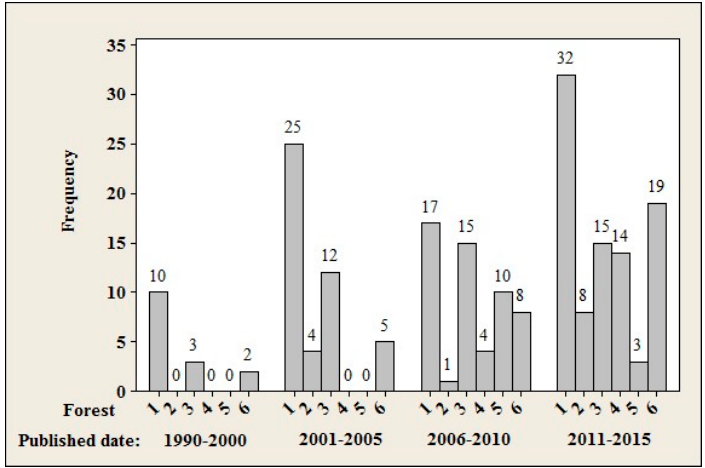
Figure 6. Summary of forest conditions of ITCD and related literature by publication date (Forest